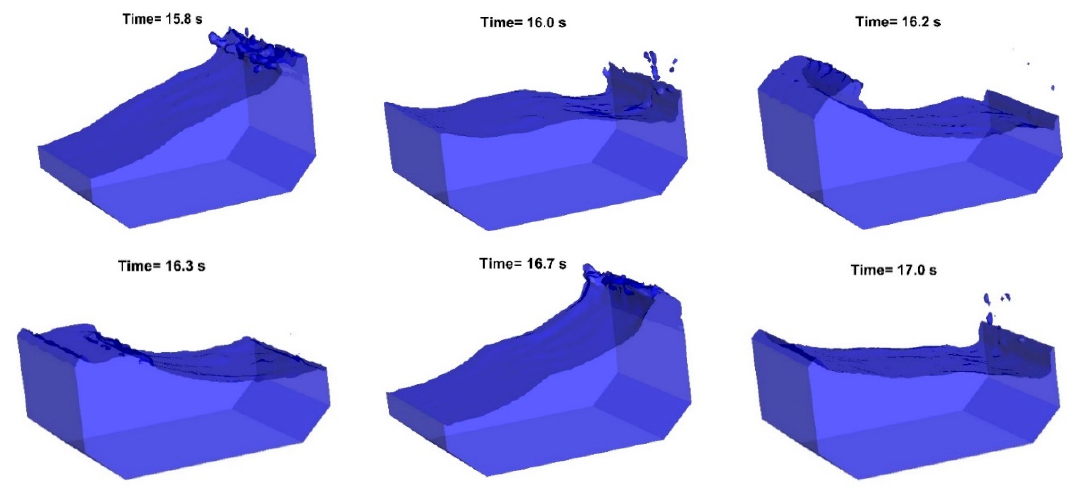
Figure 5. Numerical snapshots of the free surfaces at 15.8 s, 16.0 s, 16.2 s, 16.3 s, 16.7 s, and 17.0 s.